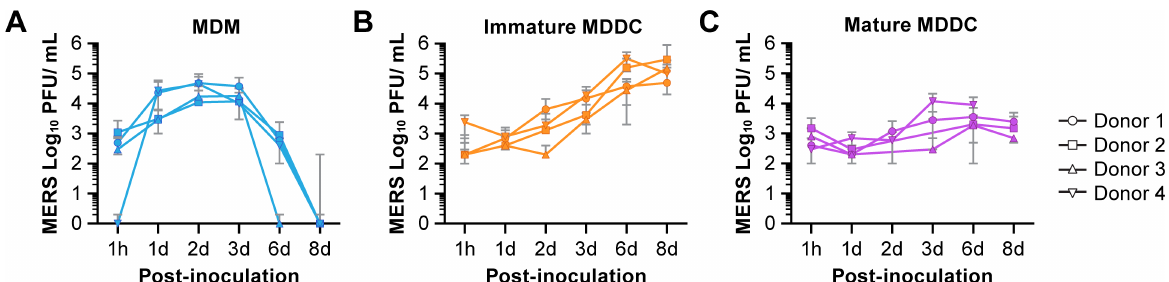
Fig 2. Viral titers from supernatants of MERS-CoV-infected macrophages and dendritic cells via plaque assay. (A) Macrophages (MDMs), (B) immature monocyte-derived dendritic cells (MDDCs), and (C) mature MDDCs were infected at an MOI = 2 with MERS-CoV Jordan variant. Culture supernatants were collected at indicated times post-inoculation to detect viral titers. Each line represents cells from each individual donor. Titrations were performed in triplicate with data points representing the mean of the triplicate values.